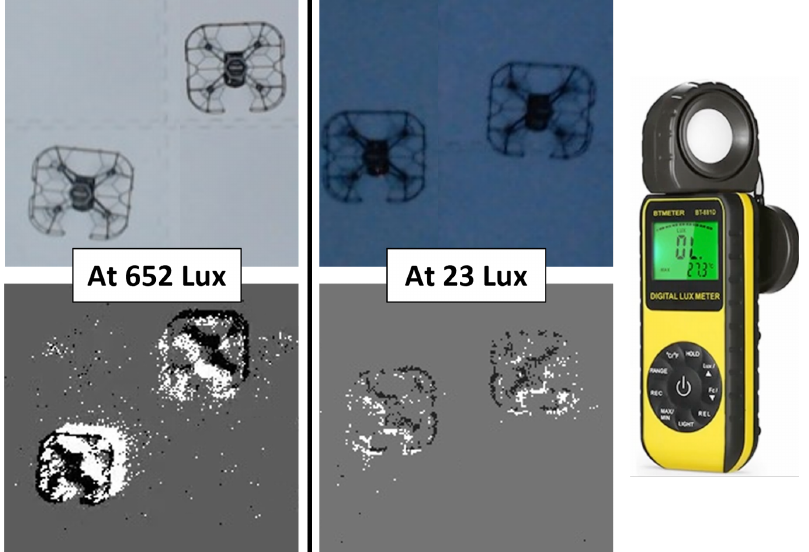
Figure 9. Detection performance was evaluated under various lighting conditions. LED light strips were used to modulate the brightness of the experiment environment. Also shown here is the Lux meter used for ambient light